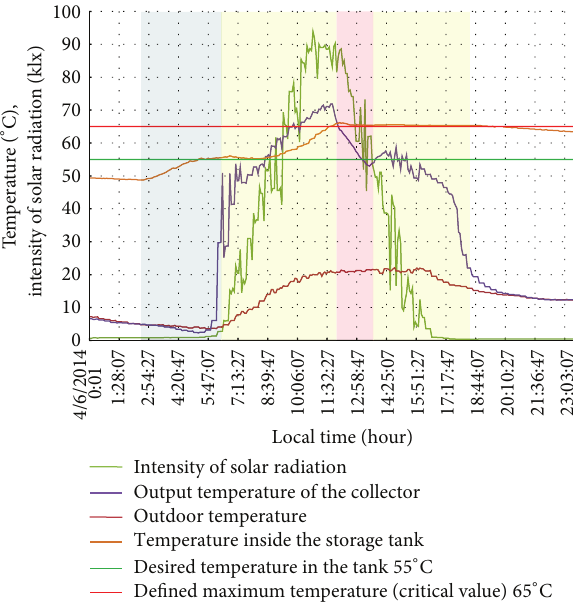
Figure 24: The courses of the monitored values in the experiment on the stagnation correction.